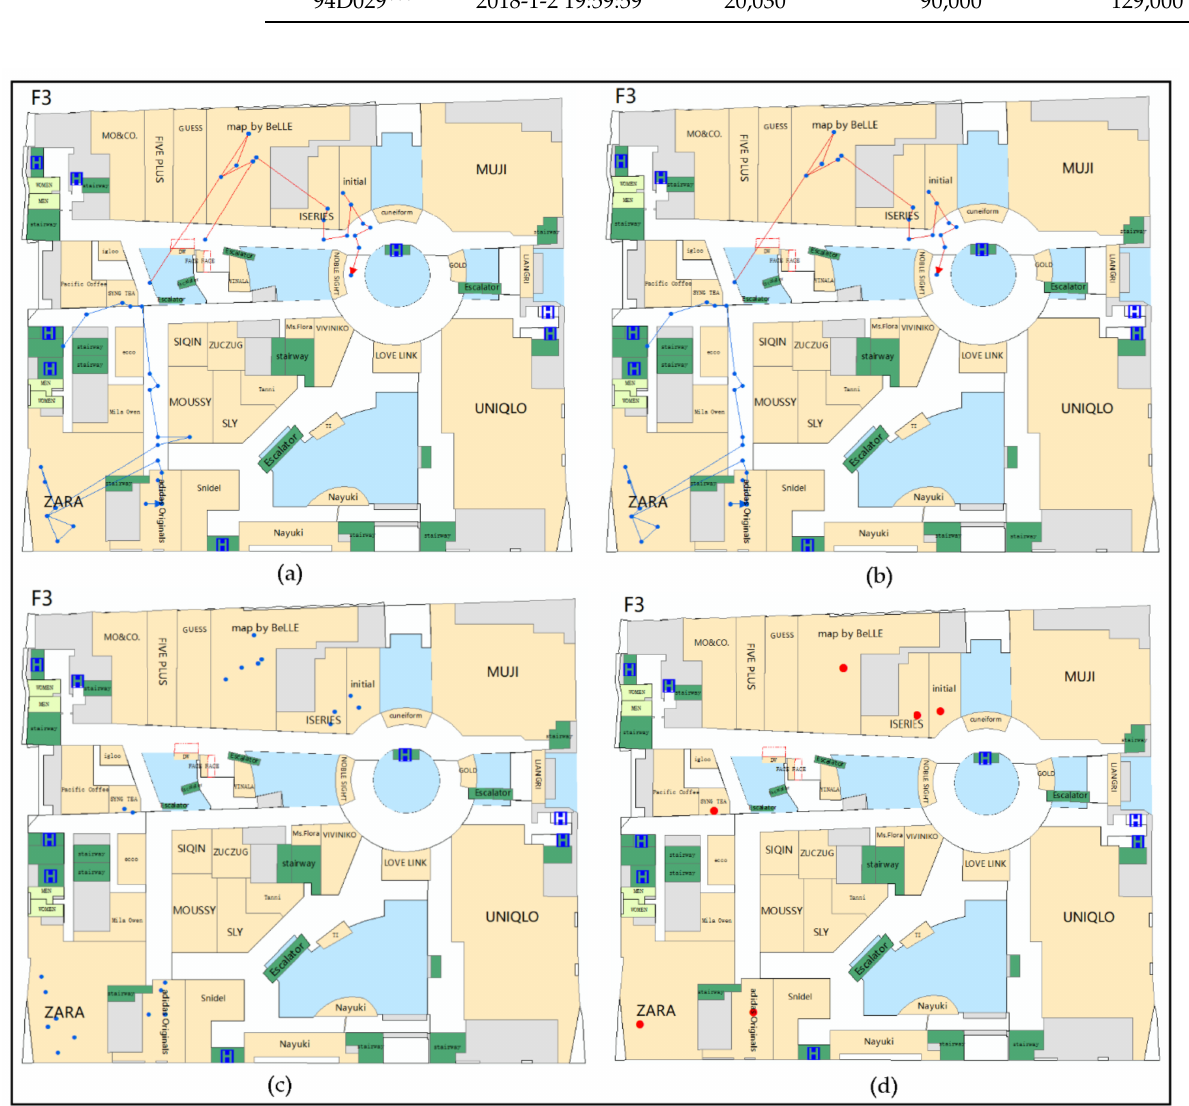
Figure 4. Trajectory preprocessing and transformation. ( a ) The raw trajectory segments on the third Floor; ( b ) the trajectory display after preprocessing; ( c ) the positioning points display after topologically choose the trajectory intersection; ( d ) the points of stay-areas on the third